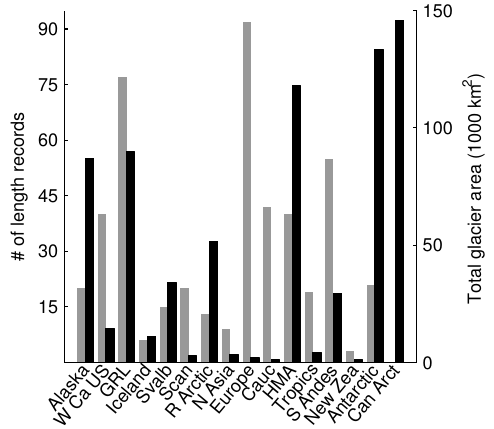
Fig. 5. Number of glacier length data points for each year in the period 1500–2010.